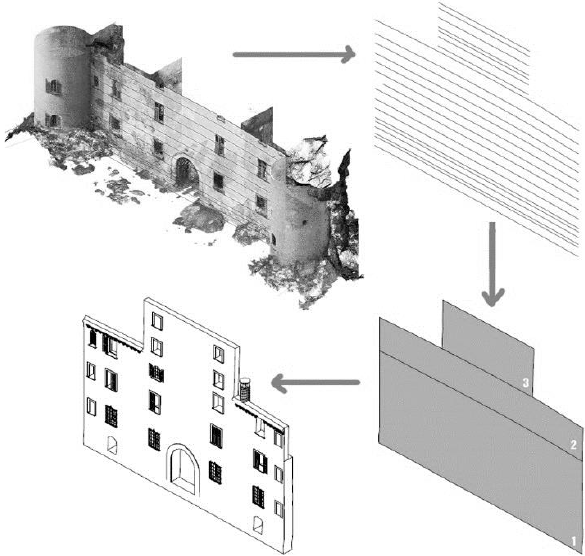
Figure 3 . Digitisation workflow to obtain an H-BIM model starting from a point cloud.